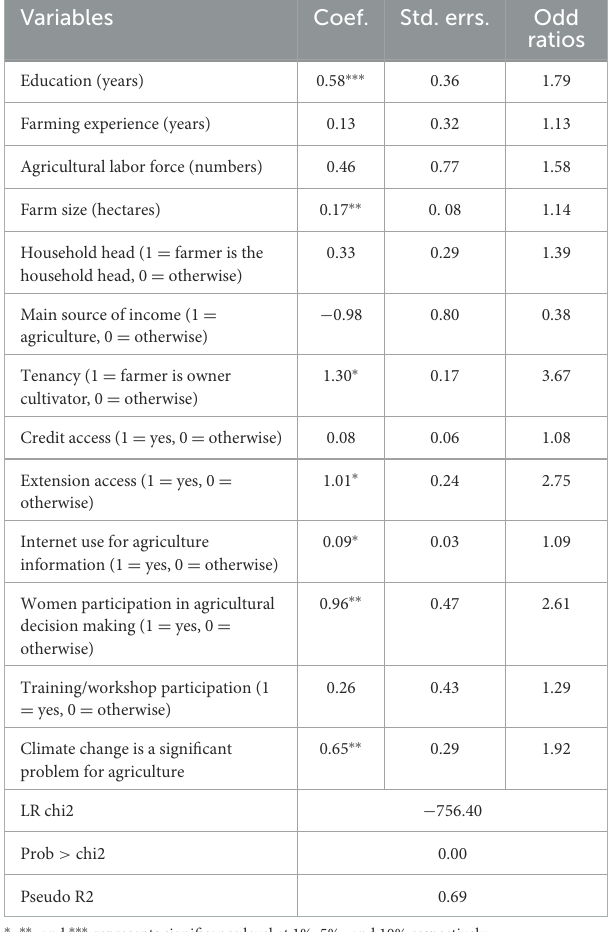
TABLE 2 Determinants of sustainable adaptation to climate